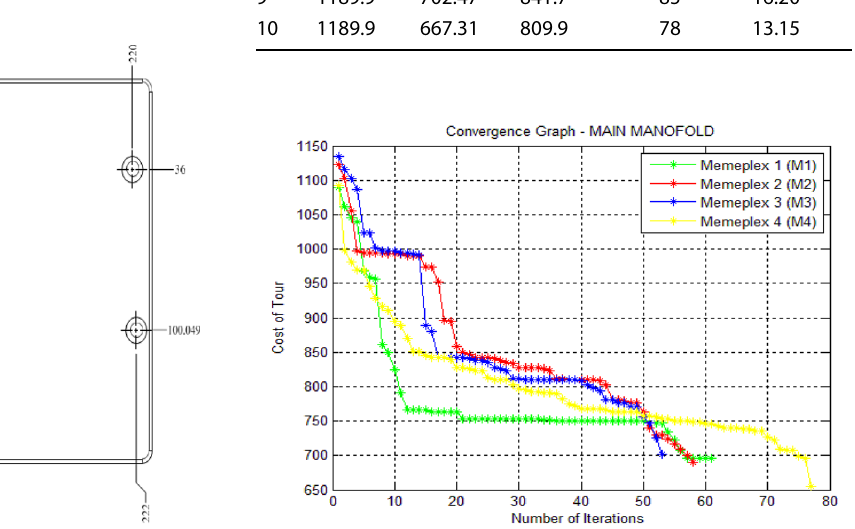
Fig. 6 MATLAB graph of the results for manifold